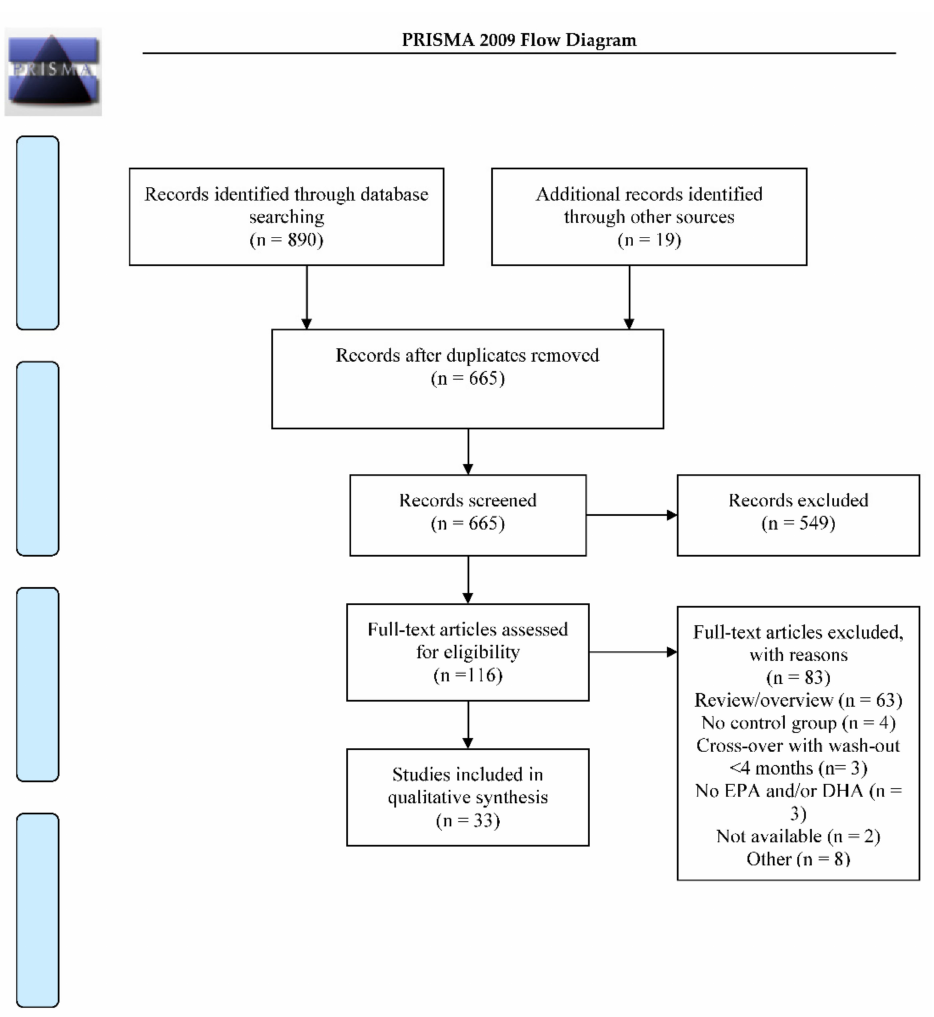
Figure 1. Flow-chart of the search strategy, adapted from [26]. EPA = eicosapentaenoic acid, DHA = docosahexaenoic